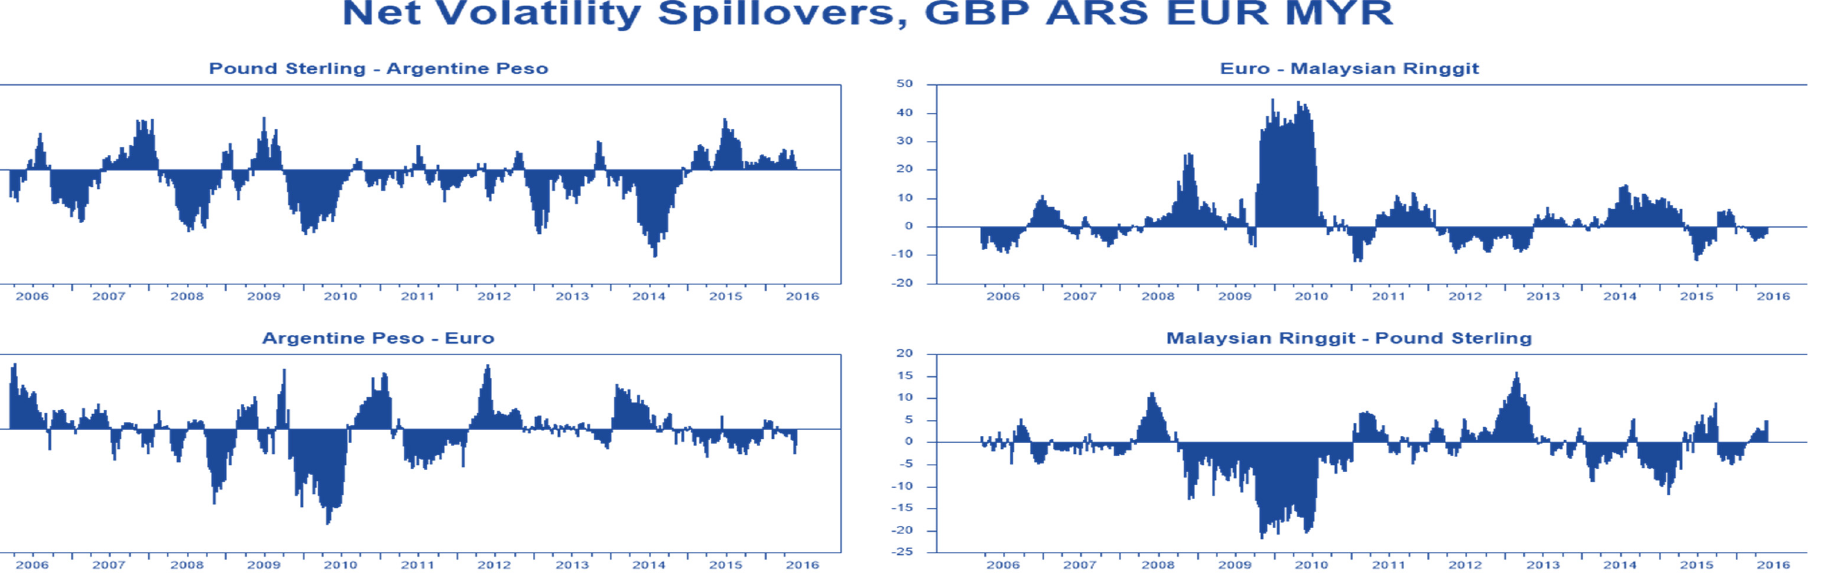
Figure 8. This figure shows the net volatility spillovers between developed and developing countries. In particular, the net volatility spillovers from/to the Pound Sterling (GBP), Argentine Peso (ARS), Euro (EUR), and the Malaysian Ringgit (MYR).